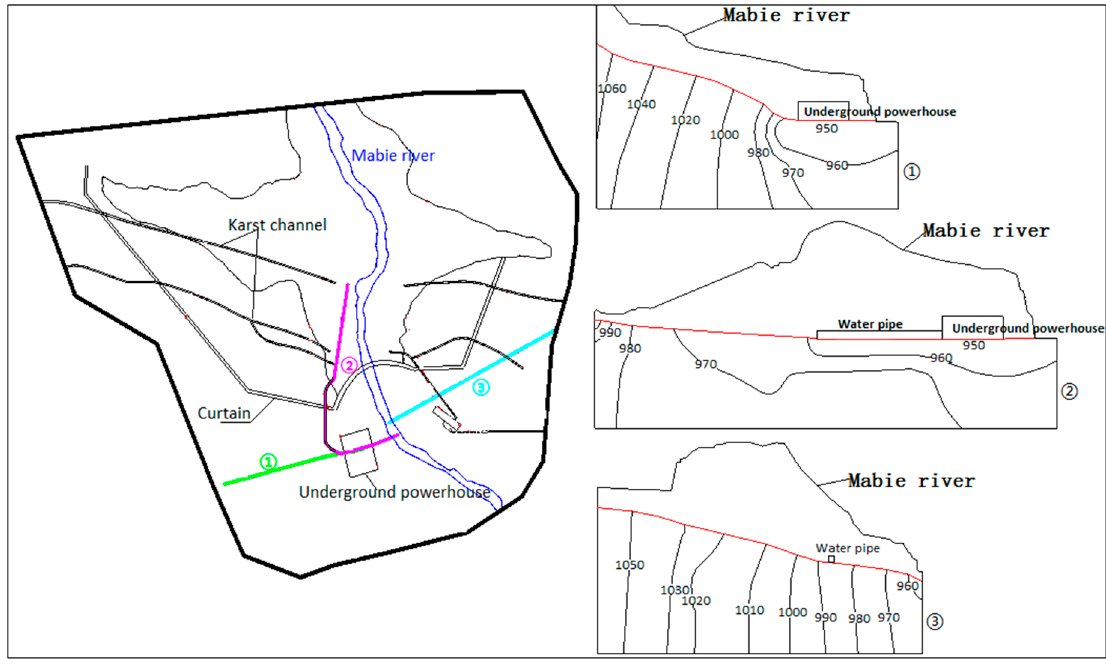
Figure 6. Groundwater level contour map of different sections during construction period.